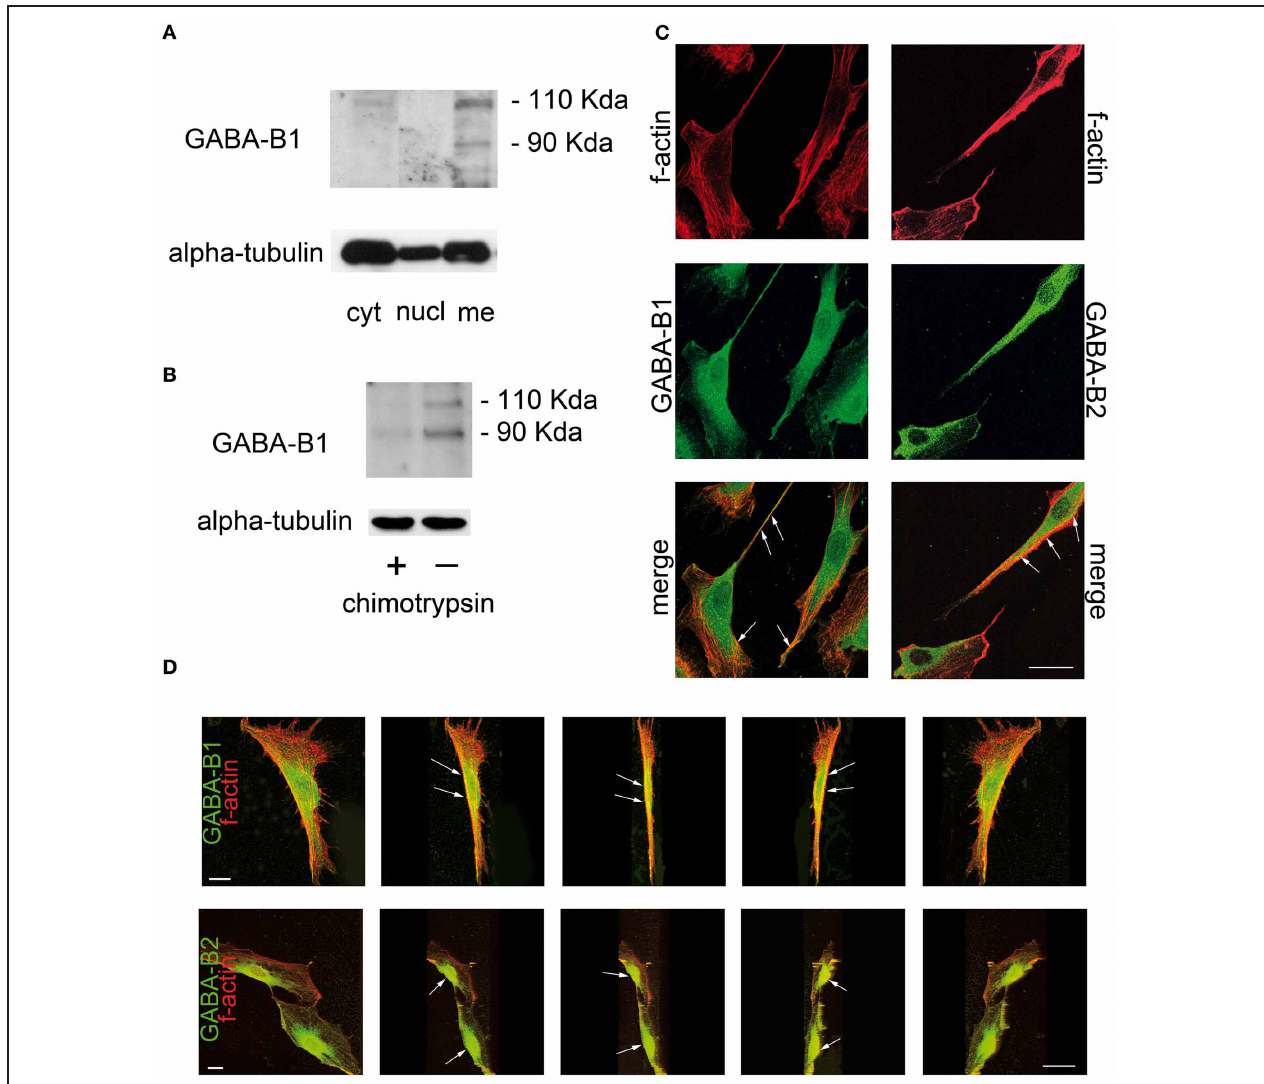
FIGURE 1 | GABA-B receptor is localized in plasma membranes of rat SC. (A) SC cultures were grown in Dulbecco’s modified Eagle’s medium with 10% fetal calf serum and they were highly pure, as characterized with a specific protein marker S100. Western immunoblot was then performed on the different SC subcellular protein fractions (nuclear, cytosolic, and membrane-enriched) separated by ultracentrifugation at 100,000 g. The antibody anti-GABA-B1 [1:250 (Magnaghi et al., 2004)] recognized two bands of ∼ 130kDa and 100kDa, corresponding to the 1a and 1b isoforms of native receptors in the membrane-enriched fraction of SC (Kaupmann et al., 1997; Ige et al., 2000). GABA-B1 was absent in the nuclear-enriched fraction, whereas two faint bands, likely corresponding to the GABA-B1 in the secretory granules, still appeared in the cytosolic-enriched fraction of SC. Equal loading was evaluated by western blot against alpha-tubulin. (B) GABA-B1 immunoblot of chymotrypsin-treated SC ( + ) showed very